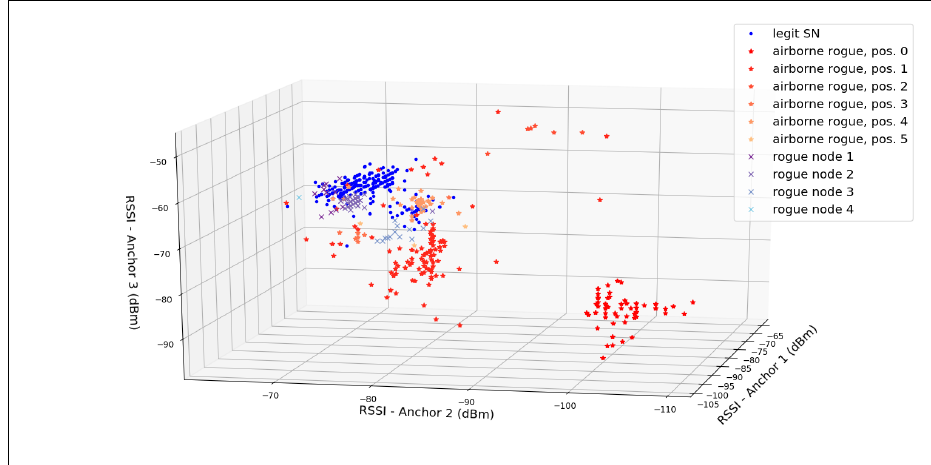
Figure 8. RSSI-triplets measured for 500 valid